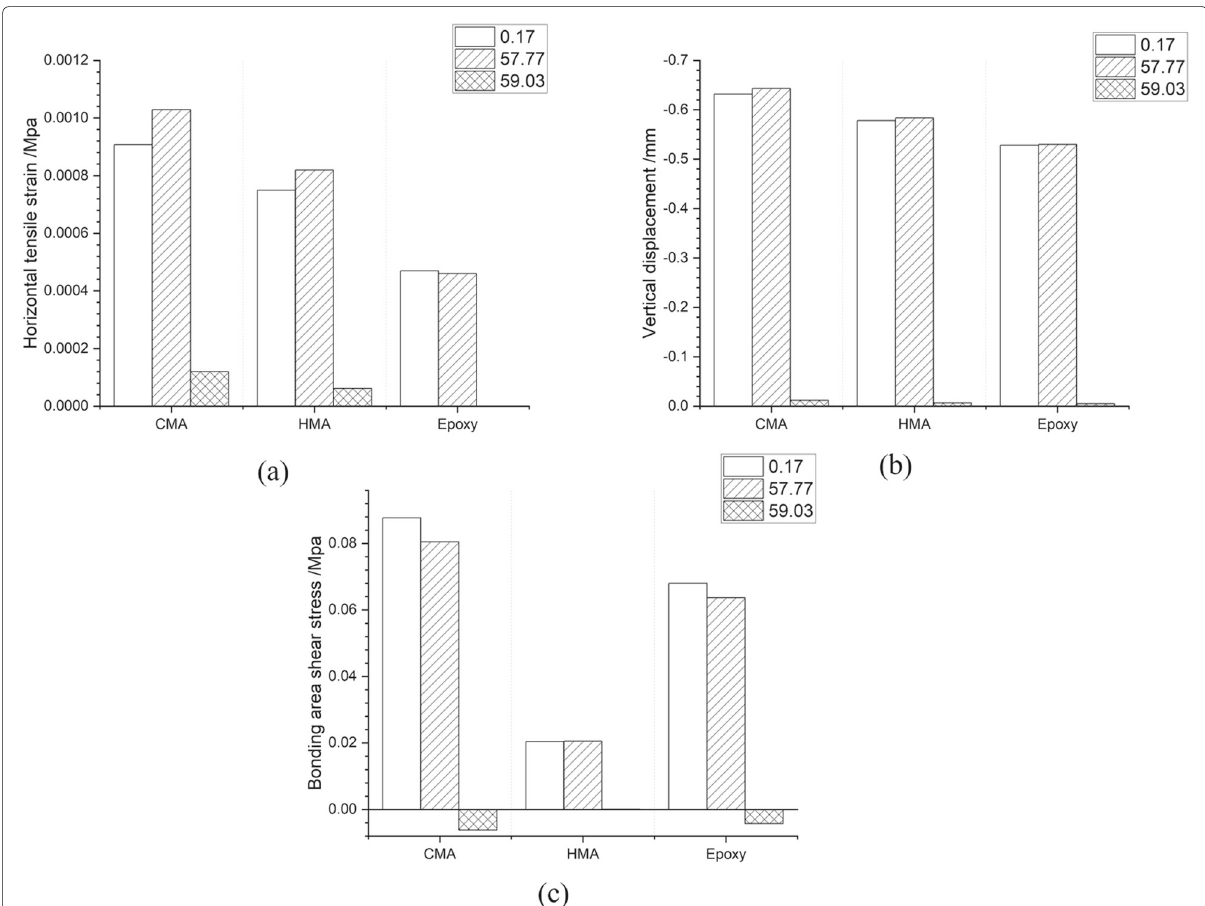
Fig. 13 Effect of material choice on a tensile strain at bottom of surface layer, b surface displacement and c shear stress at bonding